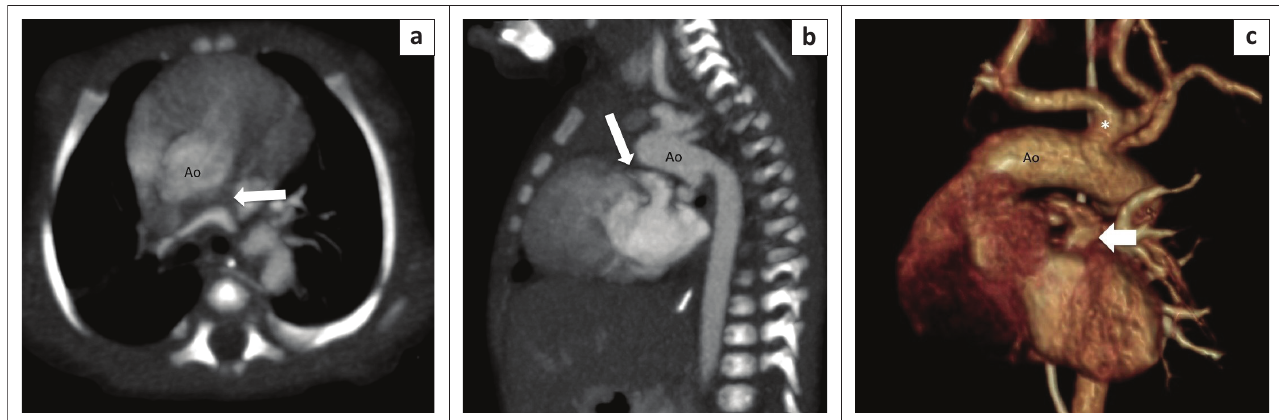
FIGURE 2: TOF-pulmonary atresia (TOF-PA) – more severe variant of TOF in an 8-week-old girl. Axial CTA MIP (a) shows non-confluence of the pulmonary arteries. Thin- section sagittal oblique CTA (b) with main pulmonary trunk and RVOT atresia. Volume-rendered CTA (c) demonstrating absence of the obliterated RVOT. Also note the bovine aortic arch